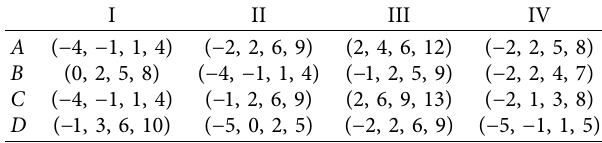
Table 10: Example 3. Table 11: Subtraction of the minimum interval in each column.